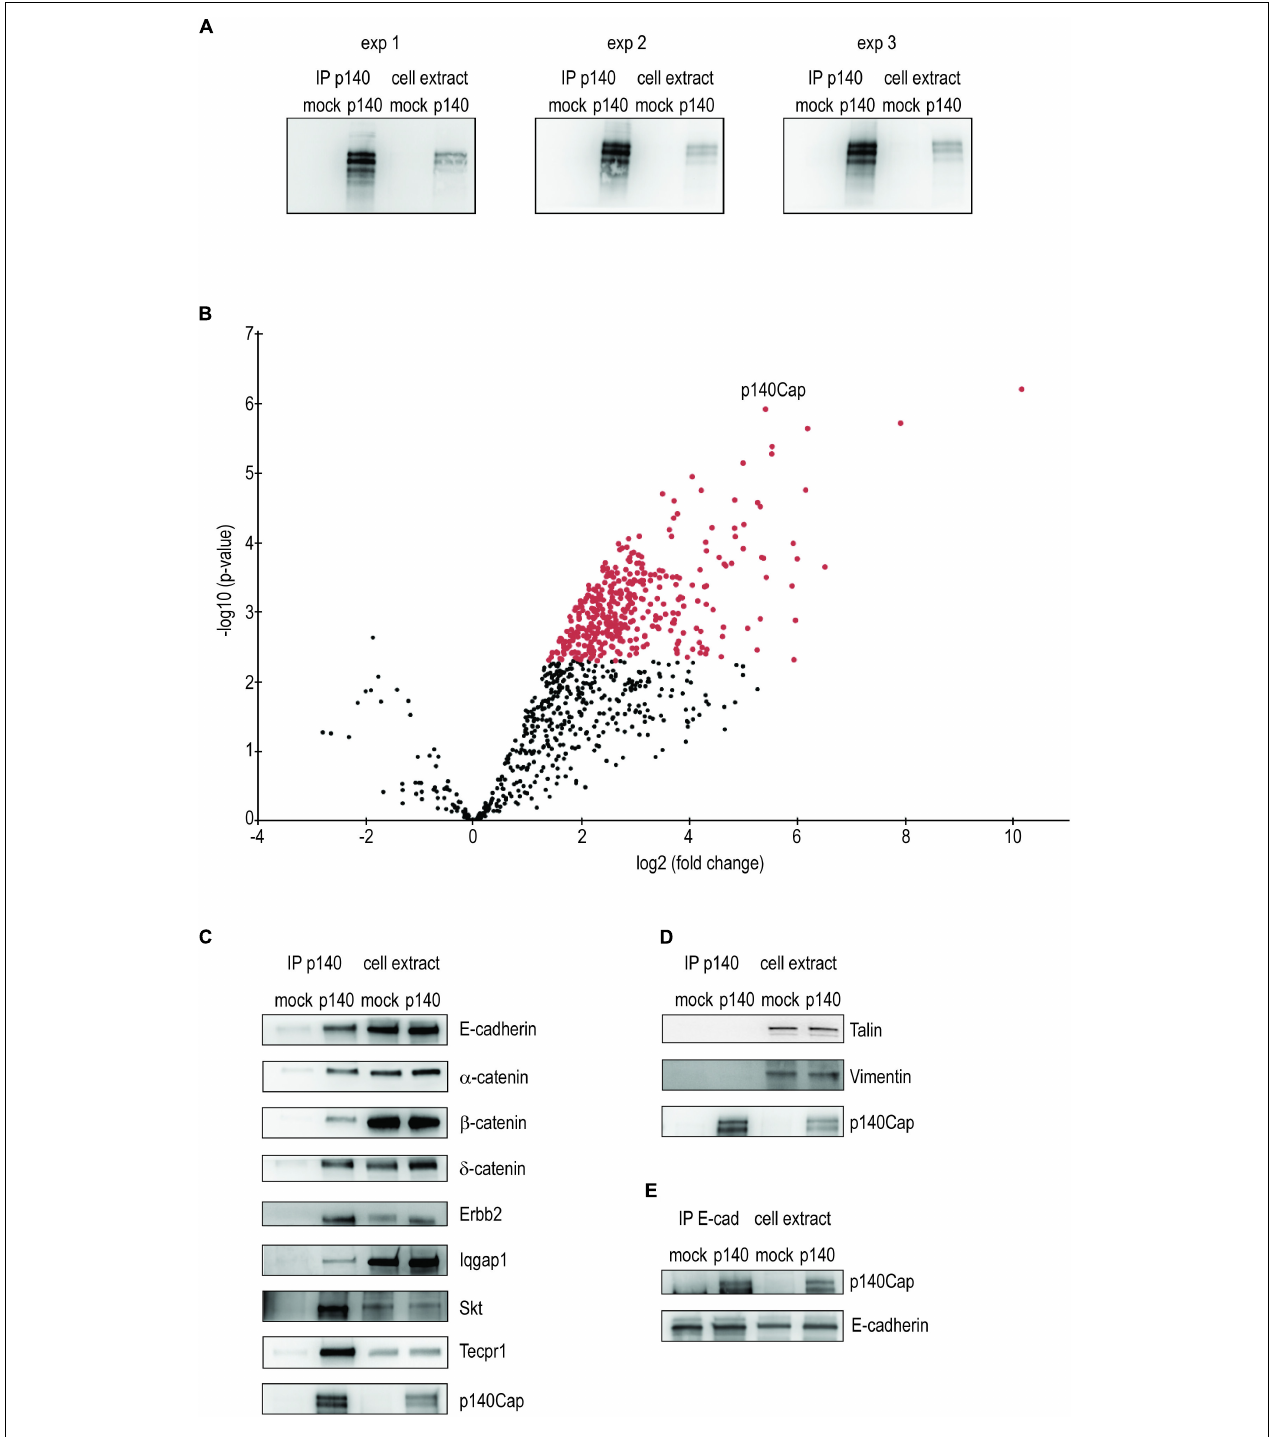
FIGURE 1 | Identification and validation of p140Cap interactors in p140Cap-TUBO breast cancer cells. Identification and validation of p140Cap interactors. (A) Validation of the breast cancer cell extracts. Western blot for p140Cap from the three immunoprecipitation of p140Cap from Erbb2 TUBO murine breast cancer cells. (B) Statistically enriched proteins in the p140Cap IP. The Volcano plot represents the log10 ( p -value, y axis) plotted against the log2 (fold change, x axis) for proteins quantified in p140Cap IPs from mock and p140Cap KO, used as negative control. 373 different proteins, including p140Cap (arrowhead) were found significantly enriched in p140 samples (FDR ≤ 1%, ≥ 4-fold enrichment) are shown as red dots. (C) Validation of synaptic p140Cap interacting proteins identified in the interactome. Co-immunoprecipitated proteins are shown on the left. (D) Negative controls by Western blot of Talin and Vimentin. (E) Reverse validation for p140Cap interacting protein